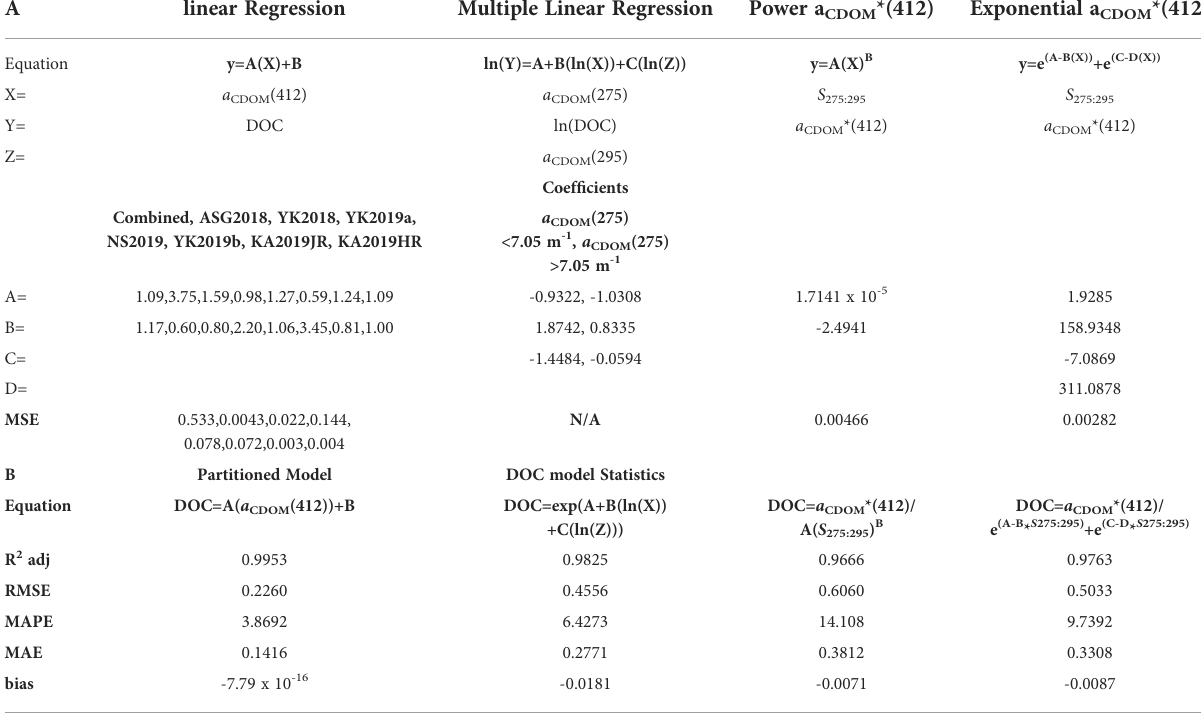
S275:295(nm -1 ) is the CDOM spectral slope coef fi cient determined by a nonlinear fi tting routine between 275-295 nm and a CDOM *(412) is the speci fi c absorption coef fi cient computed by